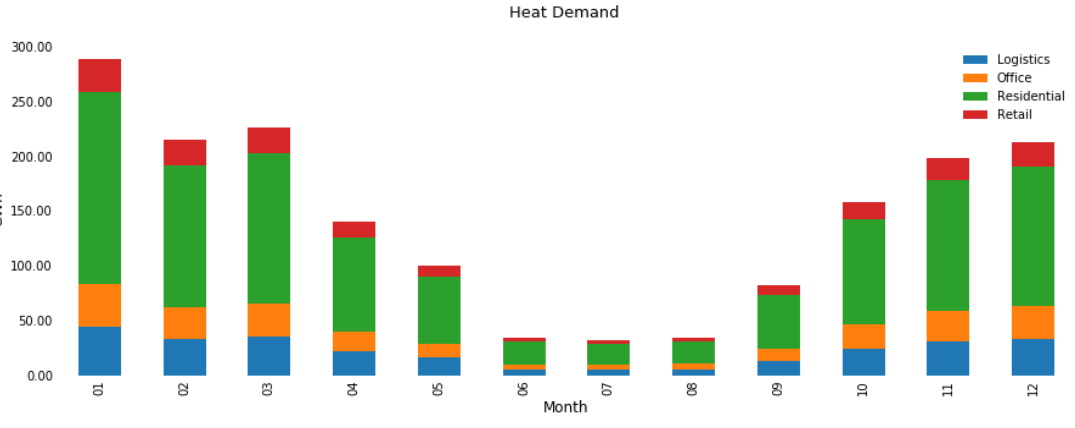
Figure 2. Heat demand of the built environment.